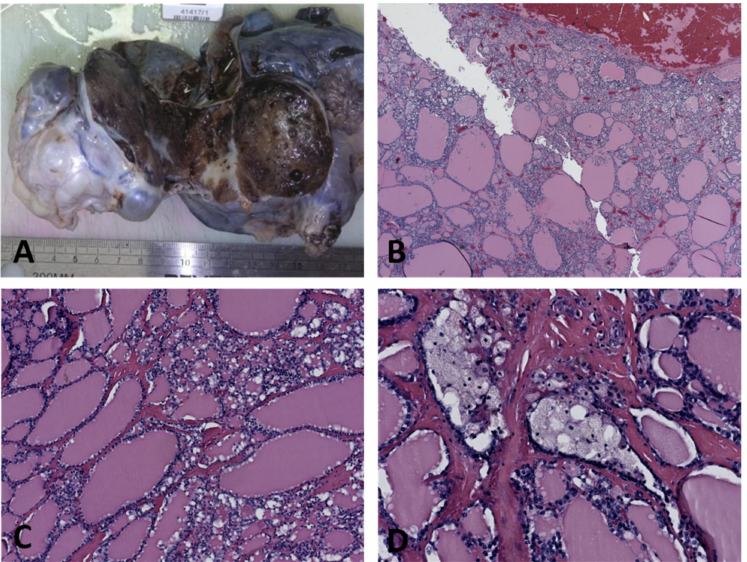
Figure 17. Struma ovarii in a 67-year-old patient: ( A ) Large ovarian mass with composite appearance, including thyroid-like areas, multiple cystic areas with colloid like content, variably hemorrhagic; ( B ) Most of the lesion is composed of thyroid follicles of variable caliber, with massive zonal hem- orrhage (HE, × 25 magnification); ( C ) Anisofollicular thyroid tissue (HE, × 100 magnification); ( D ) Thyroid follicles of variable caliber, containing colloid and macrophages (HE, × 200 magnification) (courtesy of Dr. M.